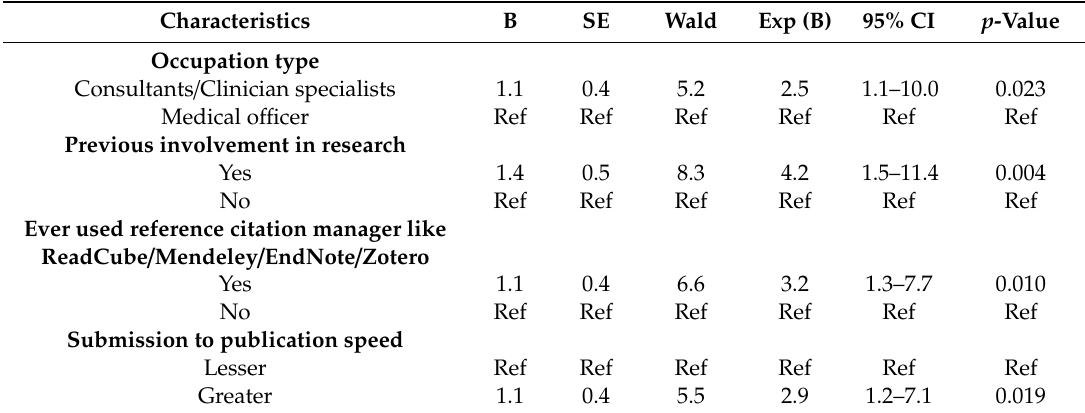
Table 6. Factors Associated with Clinicians Publication Output using Multiple Logistic Regression (Backward Wald) ( n =